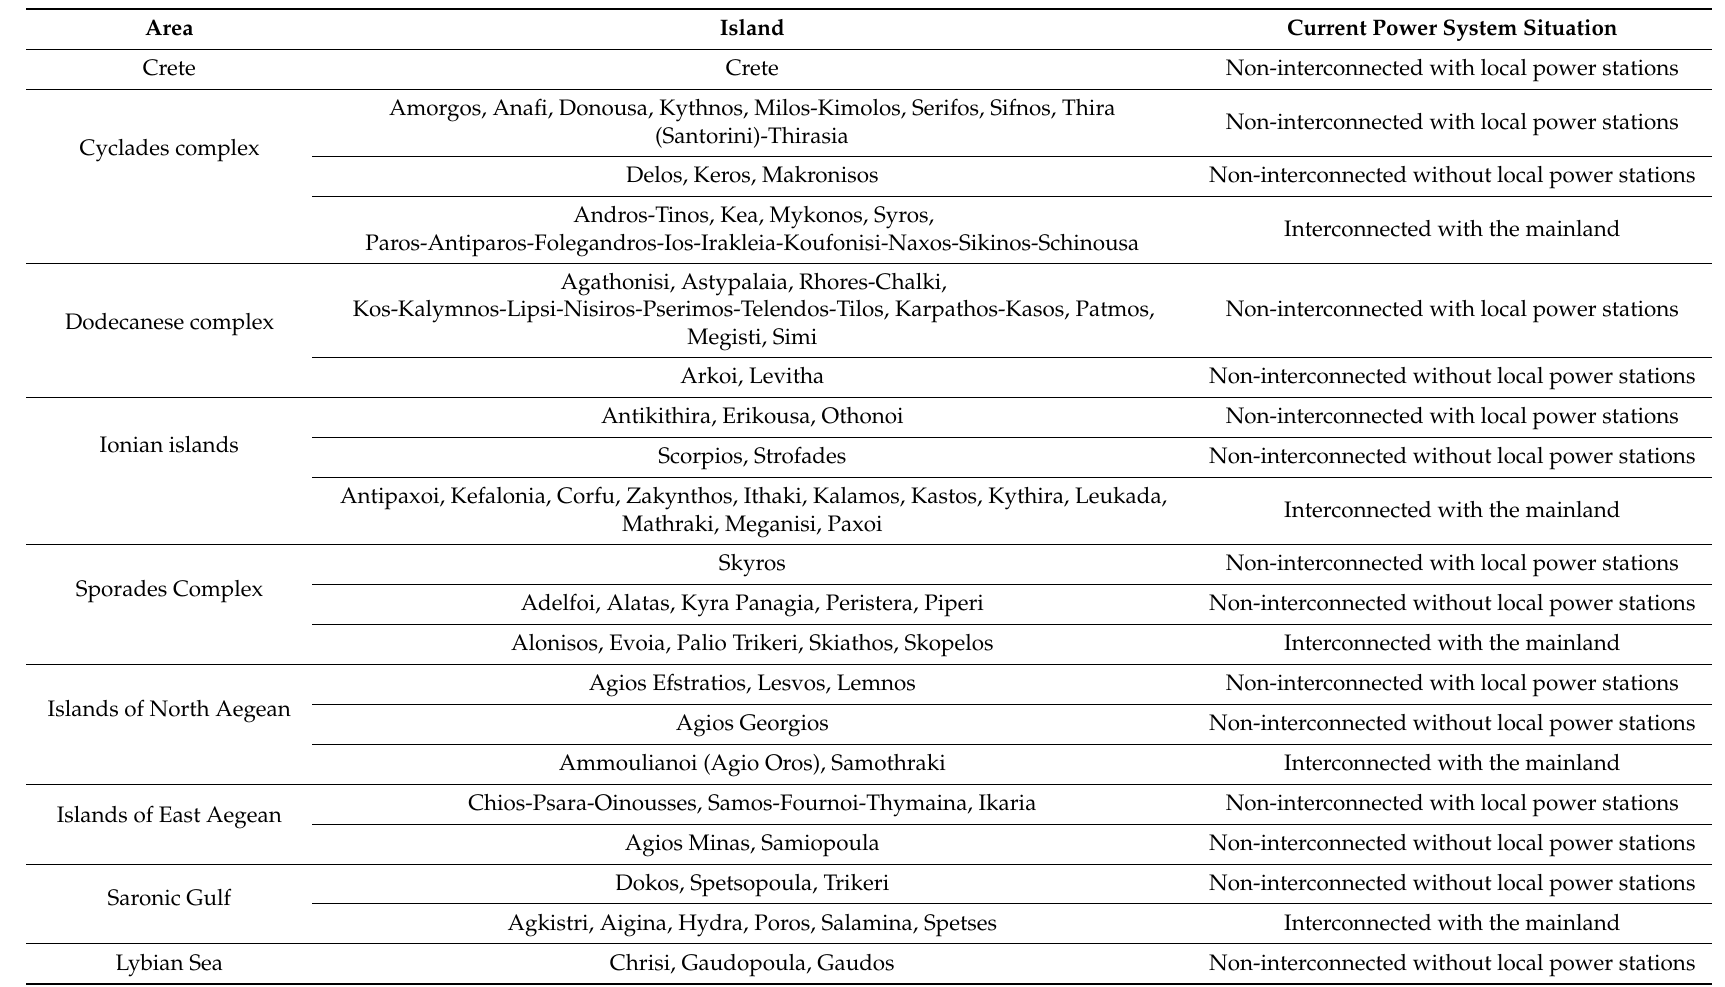
Table 2. Power system situation of the main Greek islands at the end of